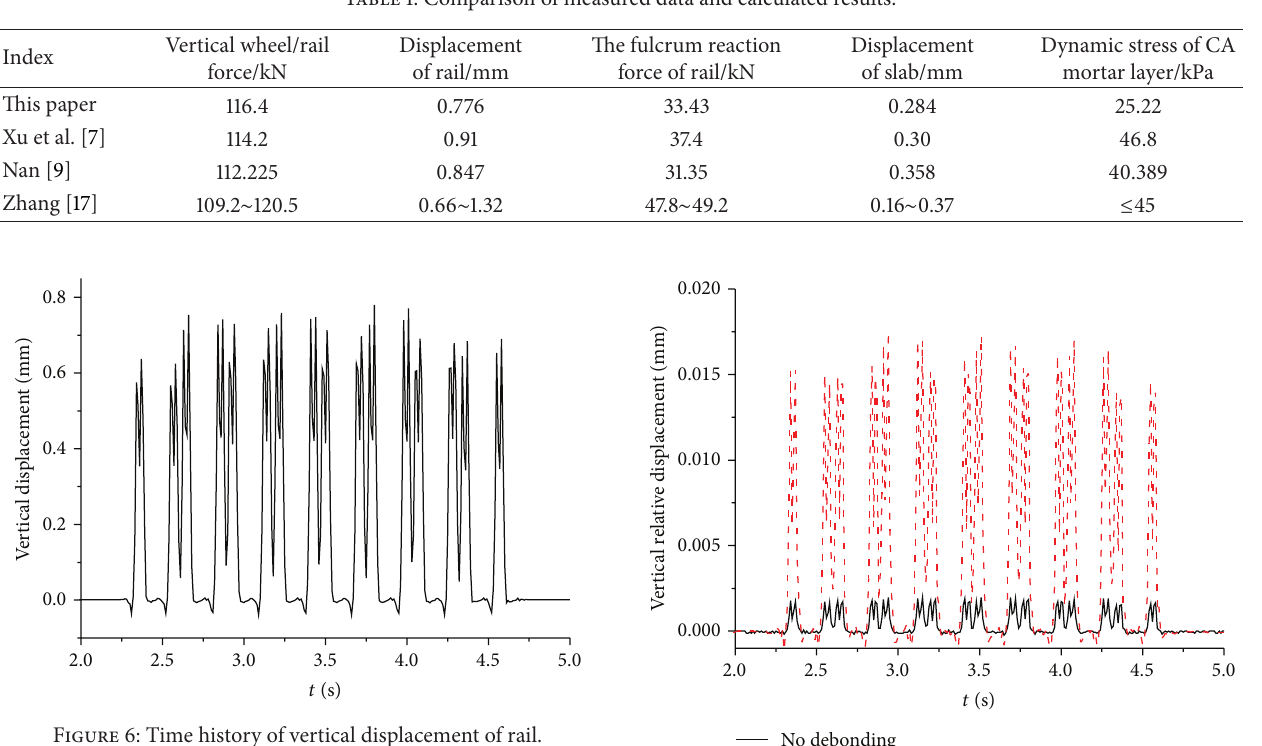
Table 1: Comparison of measured data and calculated results.